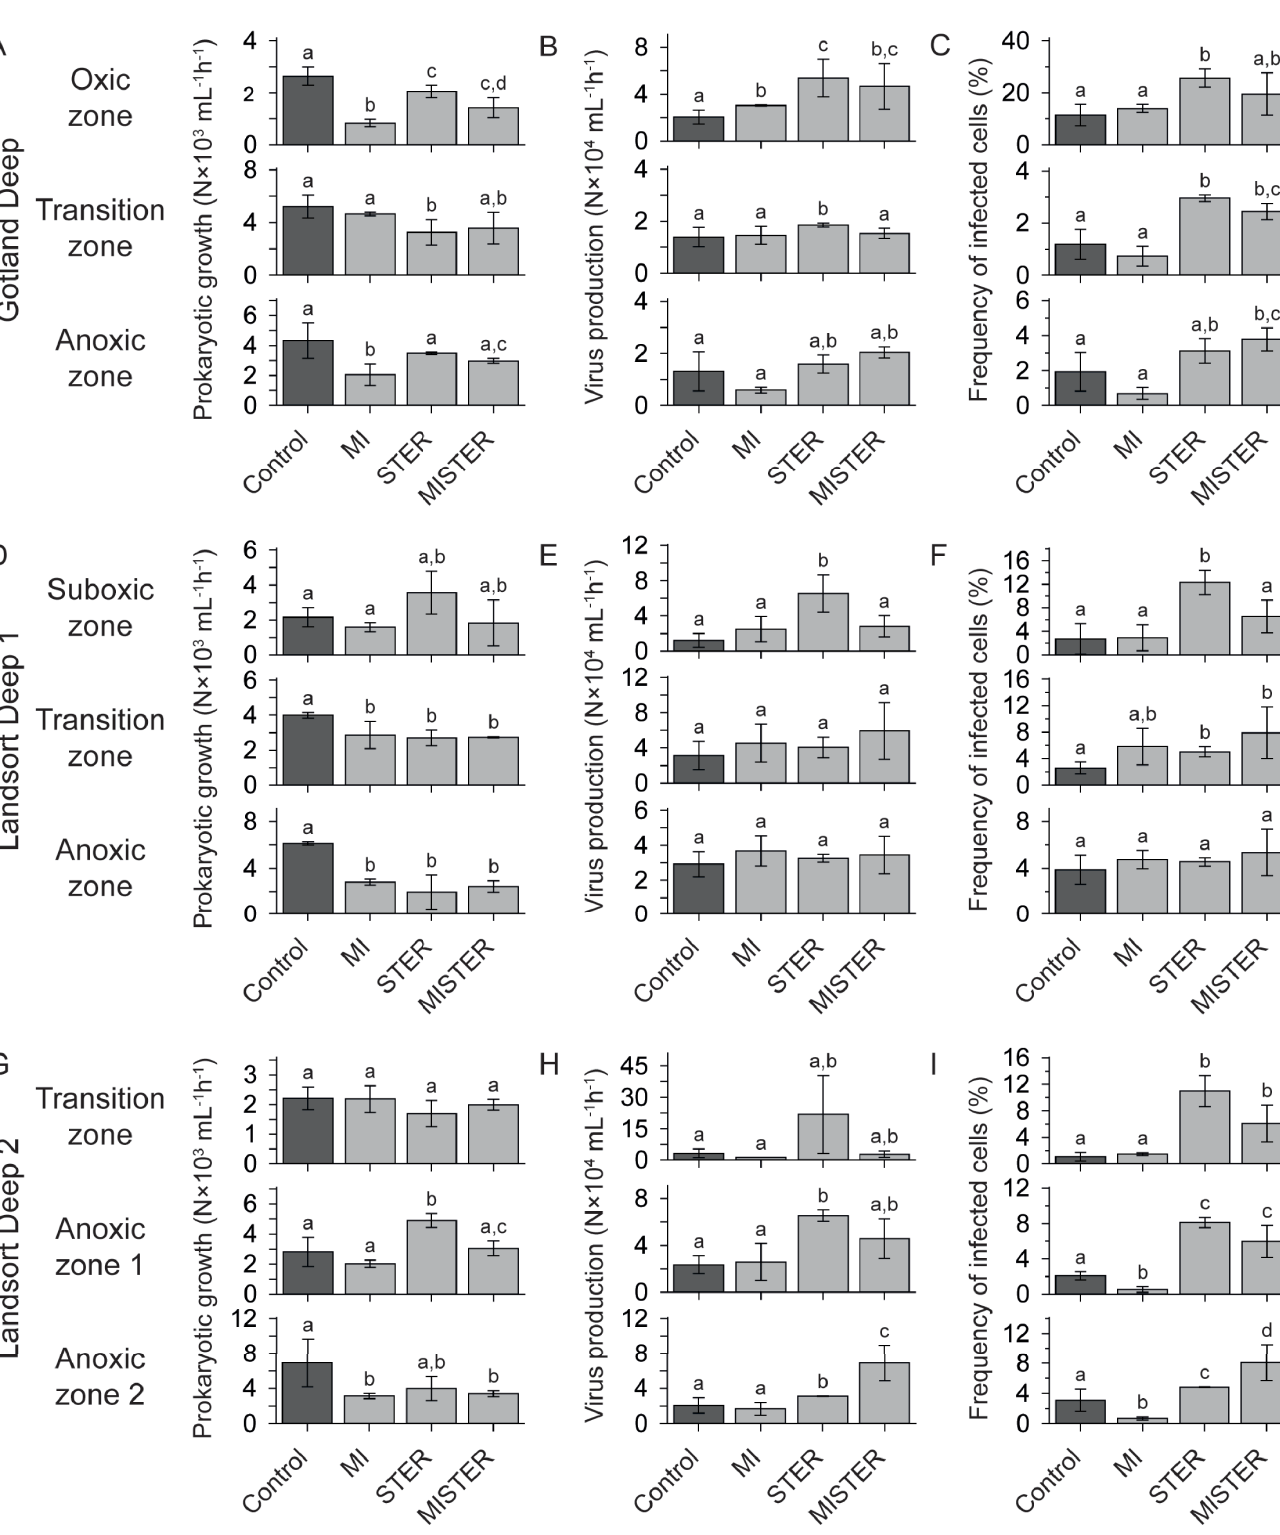
PLOS ONE | https://doi.org/10.1371/journal.pone.0220716 August 6,